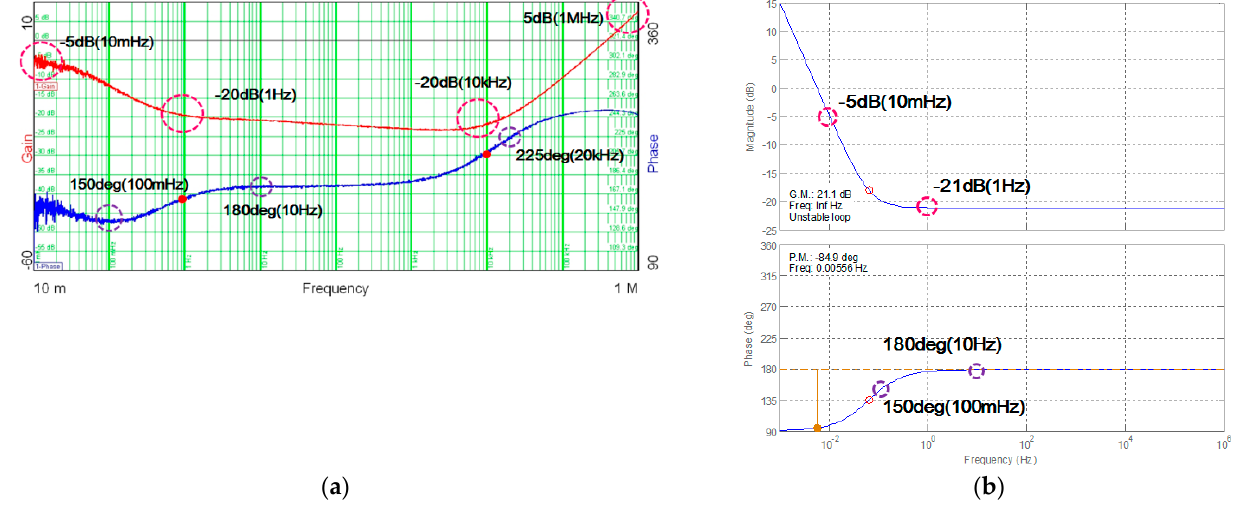
Figure 10. Measurement and approximation results of the frequency response of the battery pack at the nominal voltage: ( a ) measurement and ( b ) approximation [28].